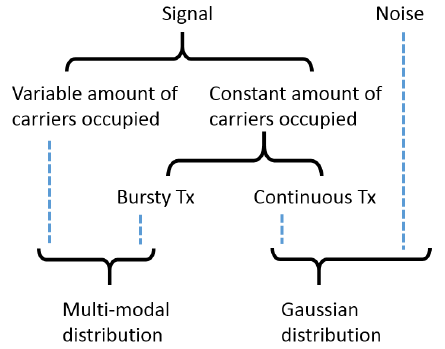
Figure 5. The categories of signals and the corresponding